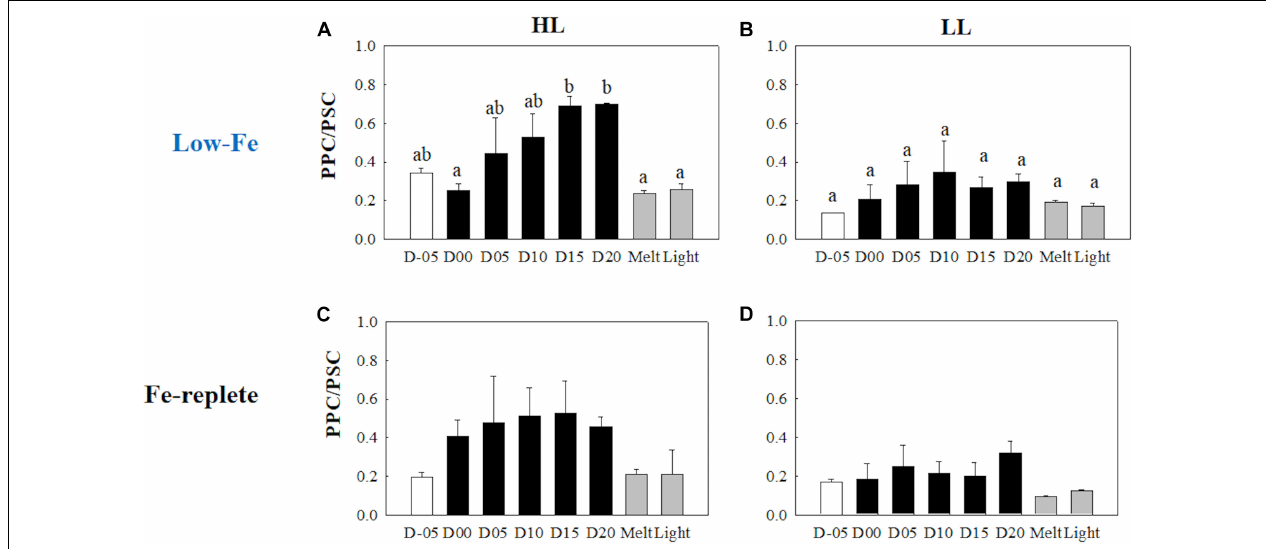
FIGURE 11 | Ratio of Photoprotective to photosynthetic carotenoids (PPC/PSC) at each sampling time point during the ice tank incubation experiments. Panels (A,B) show PPC/PSC ratios of the low-Fe ice tank runs in this study, whereas panels (C,D) show those of Fe-replete ice tank runs modified from Yoshida et al. (2020). Left (A,C) and right (B,D) panels indicate data from the HL and LL treatments, respectively. Open, closed, and shaded bars indicate values of pre-freeze seawater, ice, melted seawater samples, respectively. Letters above bars in a panel indicate significant differences in values between sampling days with one-way ANOVA with Tukey’s test; there is no significant difference between values if a given letter is shown in the combination of letters of the counterparts. The D stands for “day,” while Melt and Light indicate values after melting and light exposure experiments, respectively. Error bars show 1 standard deviation ( n = 3). One-way ANOVA with Tukey’s test, HL: F ( 7 , 23 ) = 5.62, p = 0.002; LL: F ( 7 , 23 ) = 2.39, p > 0.05. Two-way ANOVA test with Tukey’s test, Light: F ( 1 , 46 ) = 14.52, p < 0.001; Day: F ( 7 ,